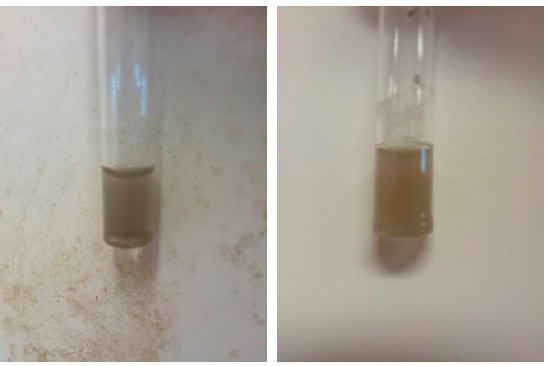
Figure 5. Dispersion of modified GPPFS@AgNPs in water before ( left ) and after ( right ) sonication.